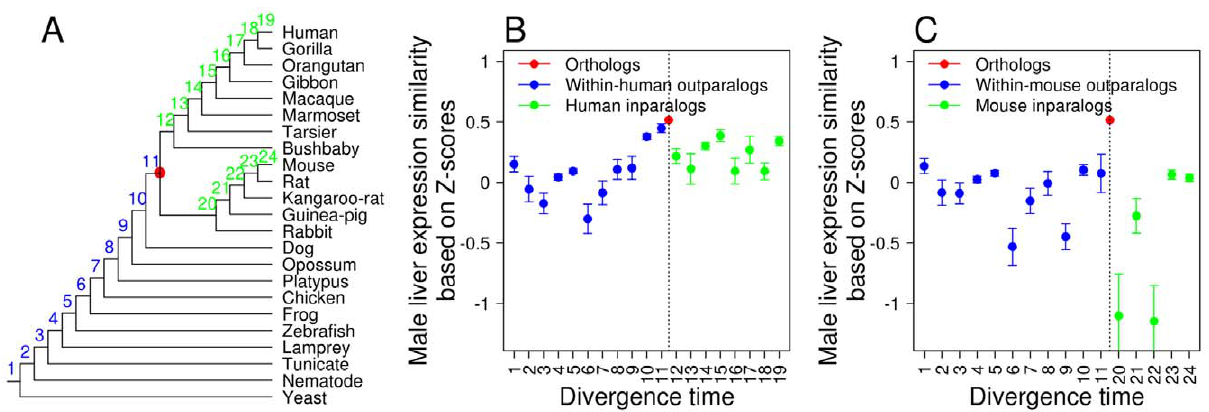
Figure 5. Z -score-based male liver expressions are more similar between human-mouse orthologs than between within-species paralogs. ( A ) A species phylogeny with numbered branches in which various paralogs were generated. The red dot indicates the time of human- mouse separation. ( B ) Z -score-based male liver expression similarity for human-mouse orthologs and within-human paralogs of different ages. Numbers on the X-axis correspond to the branches in (A). Error bars indicate one standard error. The dashed line indicates the human-mouse divergence. ( C ) Z -score-based male liver expression similarity for human-mouse orthologs and within-mouse paralogs of different ages.